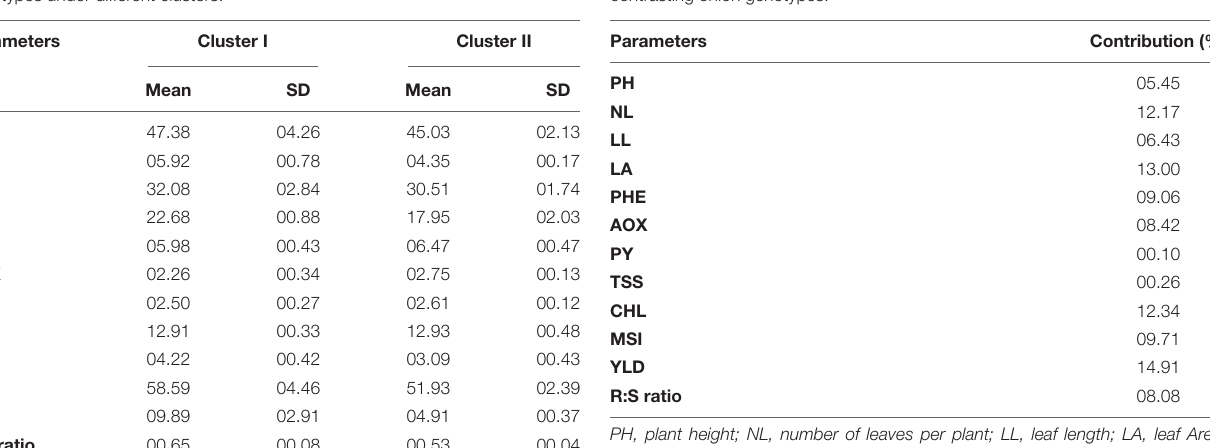
YLD SLRL * Indicates significance at the 0.05 level of significance. ** Indicates significance at the 0.01 level of significance. PH, plant height; NL, number of leaves per plant; LL, leaf length; LA, leaf Area; PHE, total phenol; AOX, antioxidant activity; PY, pyruvic acid; TSS, total soluble solids; CHL, total chlorophyll; MSI, membrane stability index; YLD, bulb yield; RL/SL, root to shoot ratio.